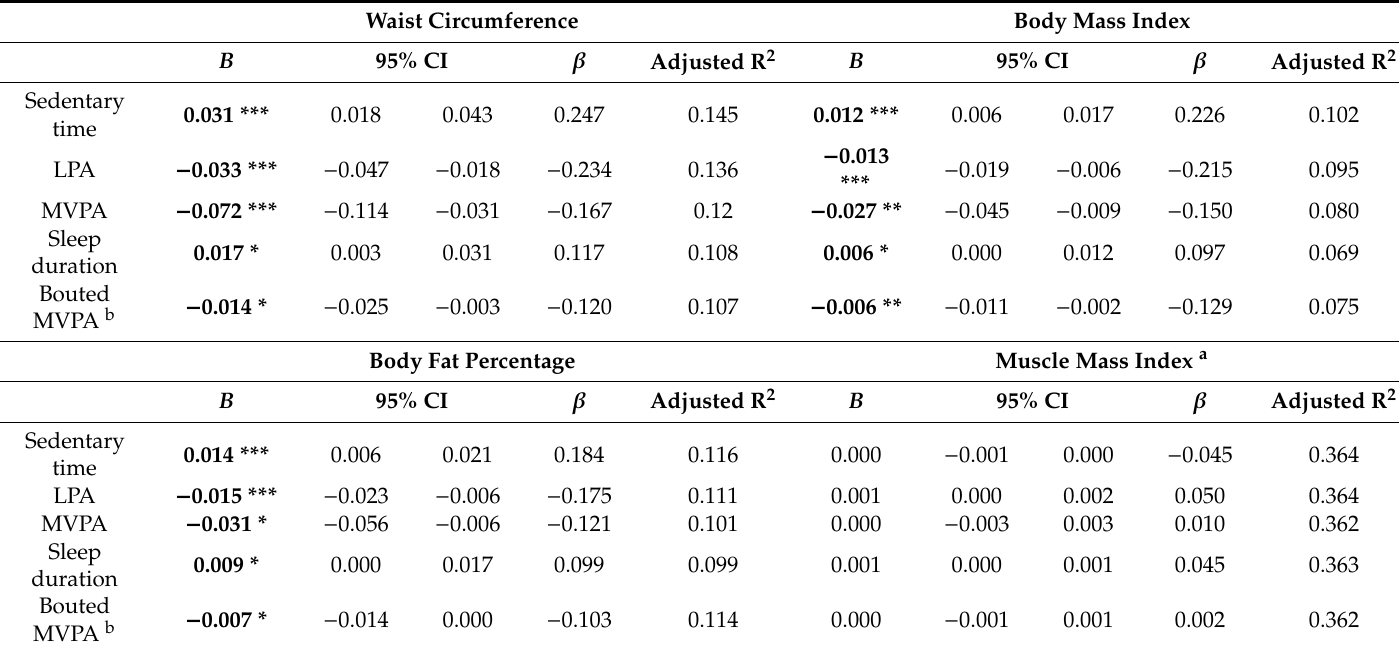
Table 2. Individual associations of sedentary time, physical activity intensity, and sleep duration with body composition